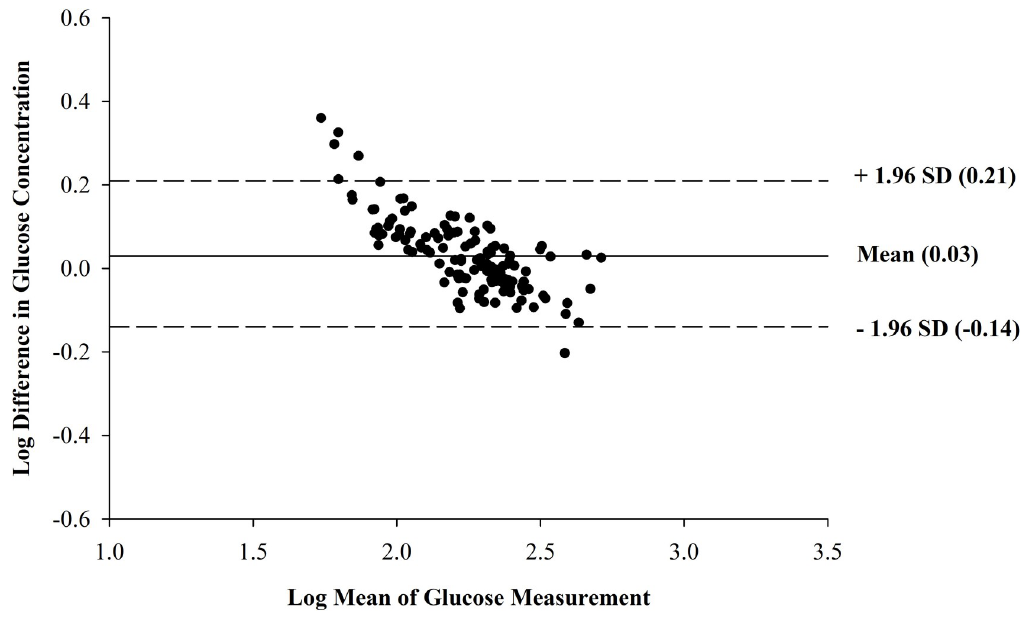
Fig 3. Bland-Altman plot of the log transformed data (N = 130 samples from 13 steers), with the mean glucose concentration as measured by the glucometer (Precision Xtra; Abbott Diabetes Care, Inc., Mississauga, ON, Canada) and the plasma preserved in sodium fluoride tubes and analyzed in a laboratory with a colorimetric assay (Stanbio Glucose LiquiColor (Oxidase) Procedure, Stanbio Laboratory, Boerne, TX, USA) on the x-axis, plotted against the difference in glucose concentrations determined by the glucometer and the laboratory on the y-axis. The mean difference is represented by the solid line (mean = 0.03) and the 95% confidence limits are represented by the dashed